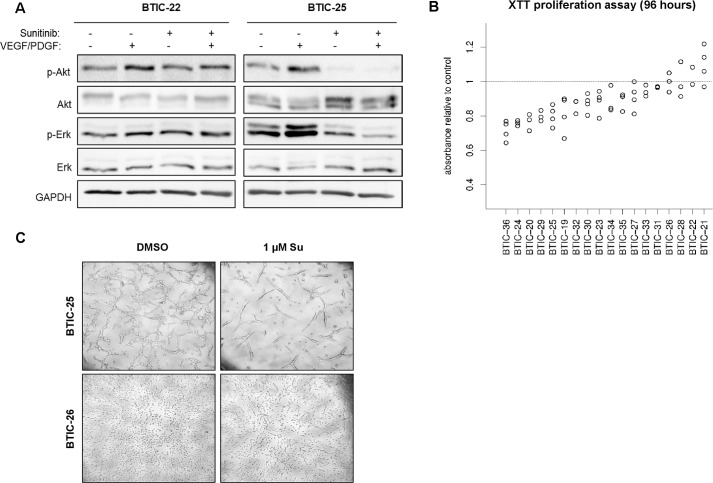
Proliferation and pathway-modulation by Sunitinib.(A) Western Blot analysis to analyze AKT phosphorylation (Ser473) was performed with 18 BTIC lines of which 2 representatives are shown. To evaluate distinct phosphorylation patterns under treatment, BTIC were treated with 1 μM Sunitinib or 0.00025% DMSO for 6 hours with growth factor supplementation (25 ng/ml) as outlined. GAPDH was used as protein loading control. (B) BTICs were incubated with 1 μM Sunitinib or 0.00025% DMSO (control), and the XTT proliferation assay was performed after 96 h. The relative difference of the mean proliferation relative to control is blotted in a dot blot graph (y-axis) against the corresponding BTIC line (x-axis). Each data point indicates the result of an individual experiment. (C) Growth pattern in a responding (BTIC-25) and a non-responding (BTIC-26) BTIC line. Representative pictures are shown for two differently responding BTIC lines.